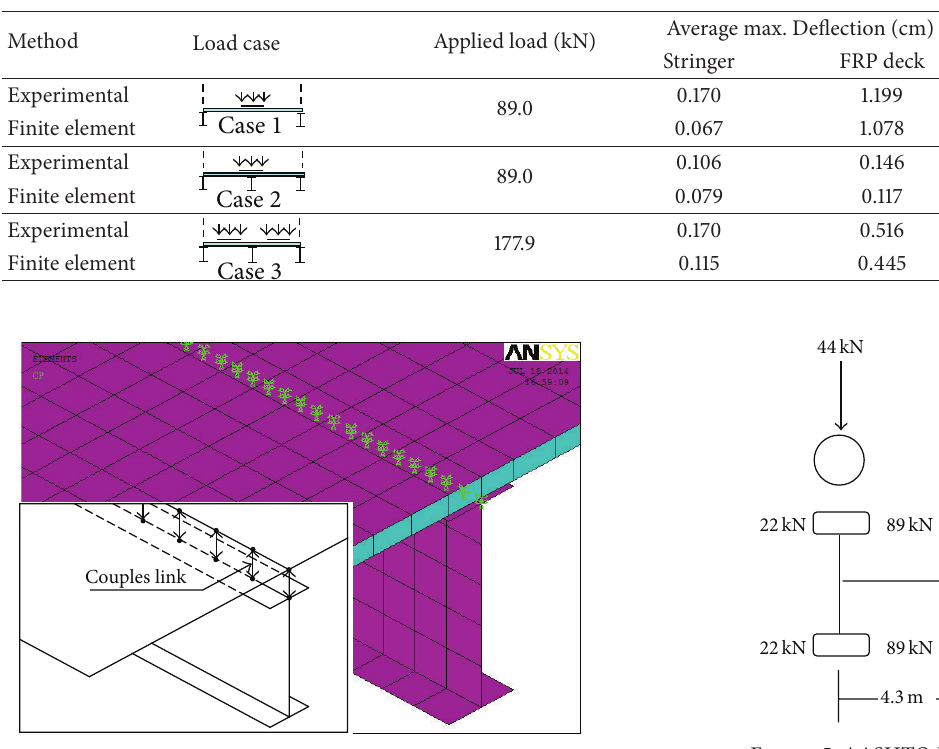
Figure 5: AASHTO HS25 semitrailer